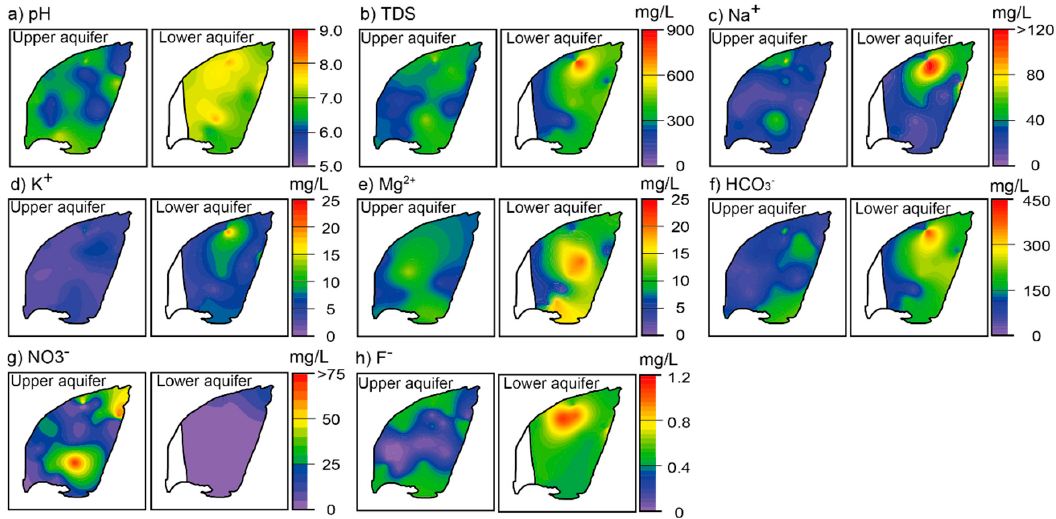
Figure 7. The spatial distribution of some hydrochemical parameters, showing distinct hydrochemical features between the groundwater from the upper aquifer and the lower aquifer in the study area.